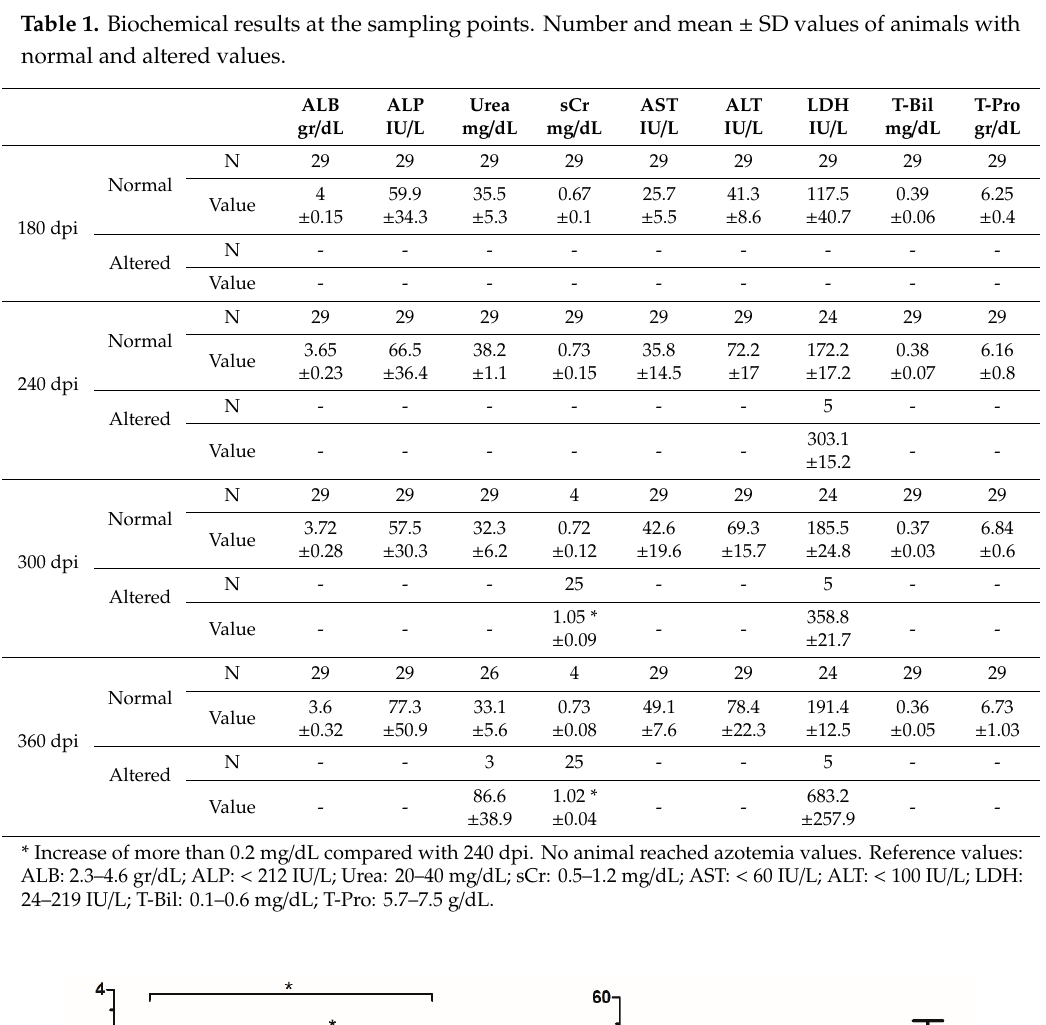
Figure 2. Graphic representation of Spearman correlation between uNGAL/C and UPC (rs = 0.485, p = 0.005).